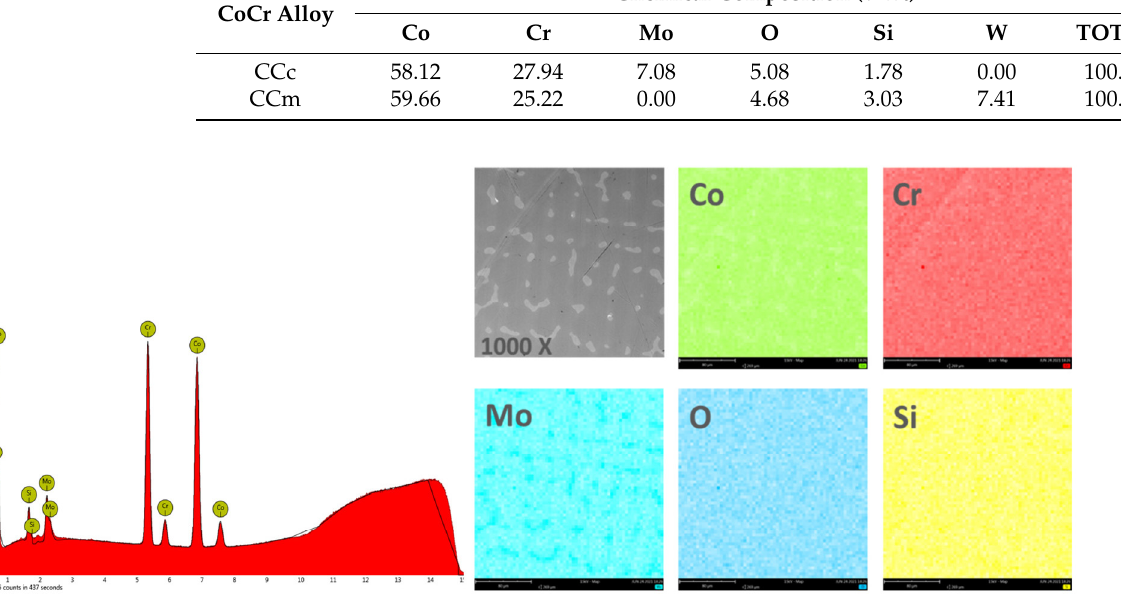
Figure 4. EDS spectra and elemental distribution for CCc samples.